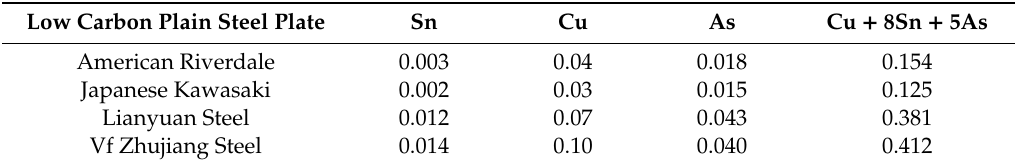
Table 1. Control standard for residual element content in low carbon steel plates for CSP plants in China and abroad, wt%